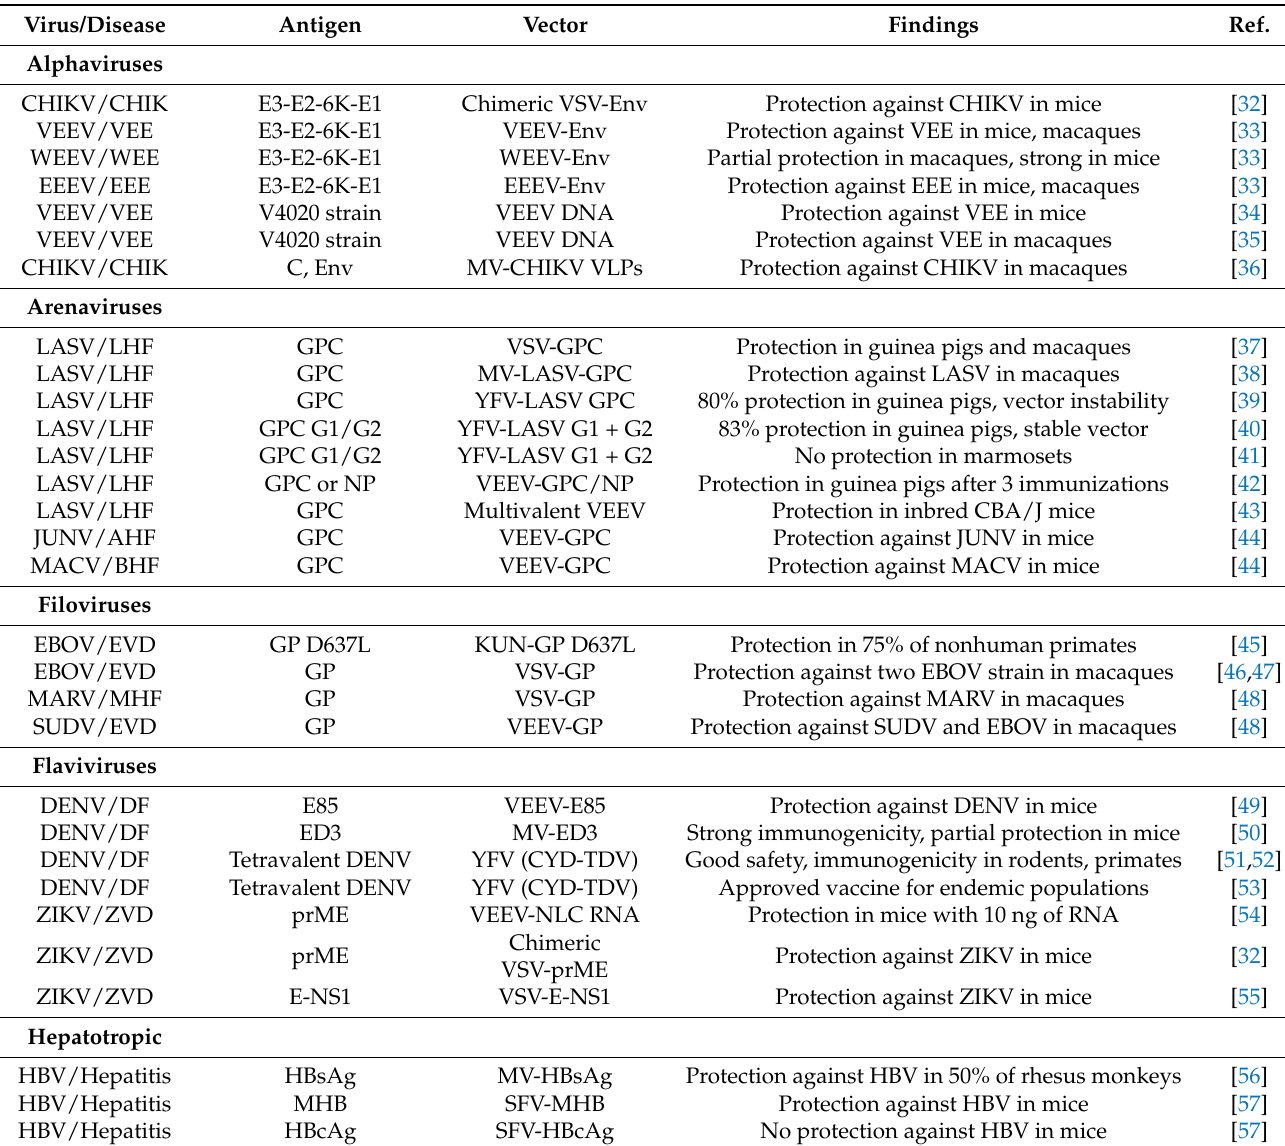
Table 1. Examples of preclinical studies on self-replicating RNA viral vector vaccines against infectious diseases.